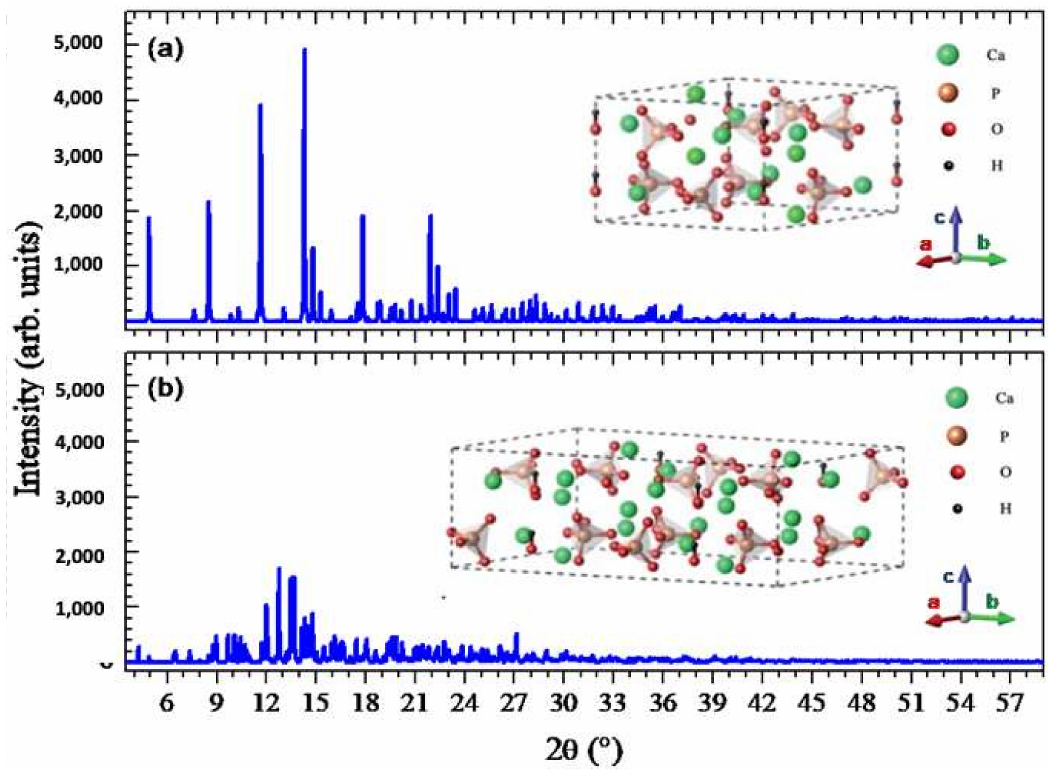
Figure 2. Calculated powder diffraction pattern using X-ray wavelength of 0.7 Å. ( a ) Hexagonal phase (space group176, P6 3 /m) and ( b ) monoclinic phase (space group 14, P2 1 /b).